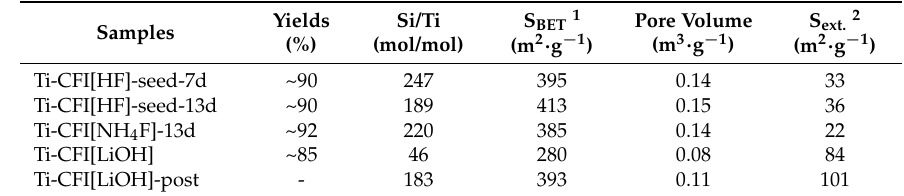
Table 1. Product yields, chemical compositions, and porosity properties of Ti-CFI zeolites from the different synthetic